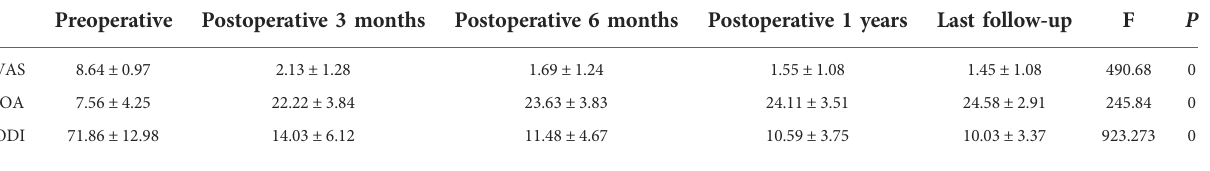
TABLE 3 Comparison of preoperative and postoperative VAS, JOA and ODI.